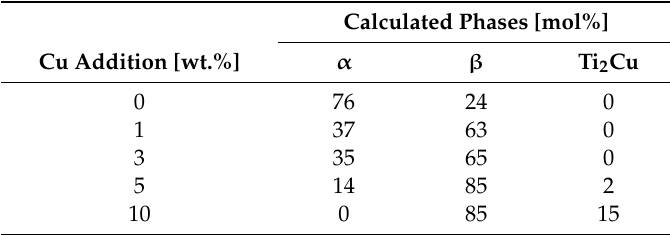
Table 5. Calculated mol% of phases of α , β and Ti 2 Cu in the investigated alloys at 747 ◦ C. Calculated Phases [mol%] Cu Addition